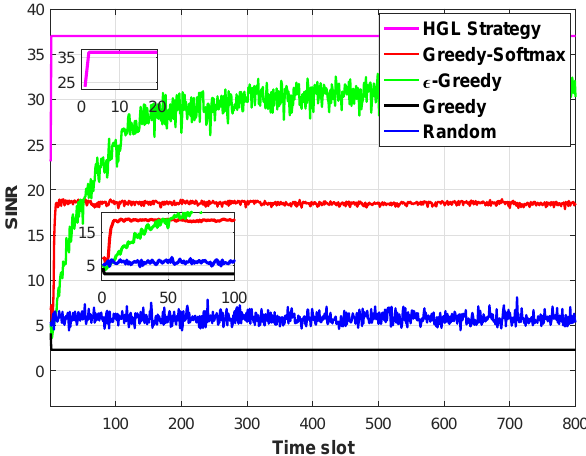
Figure 7. SINR comparison under different